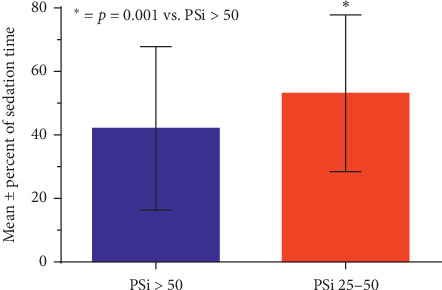
Mean ± SD percent of total case time spent with PSi 25–50 compared to percent of case time at PSi ≥50. The percent of time patients had PSi 25–50 was significantly higher than the percent of time PSi was >50.